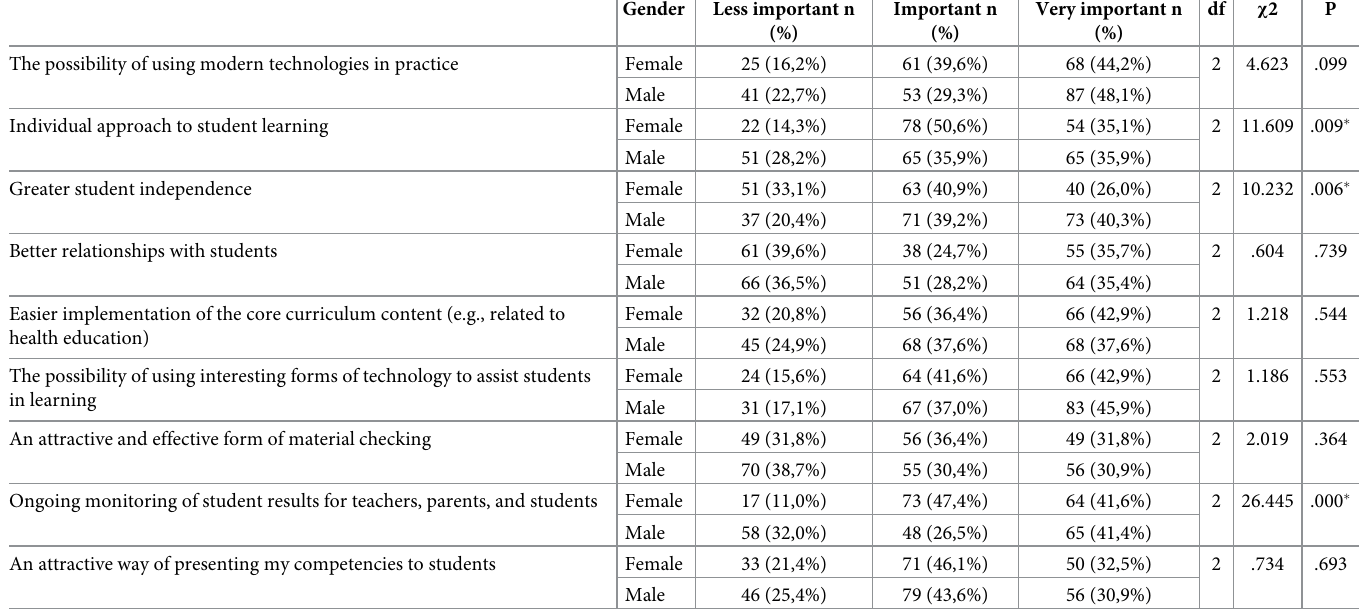
Table 1. Pets’ opinions on the advantages of online physical education teaching by gender.